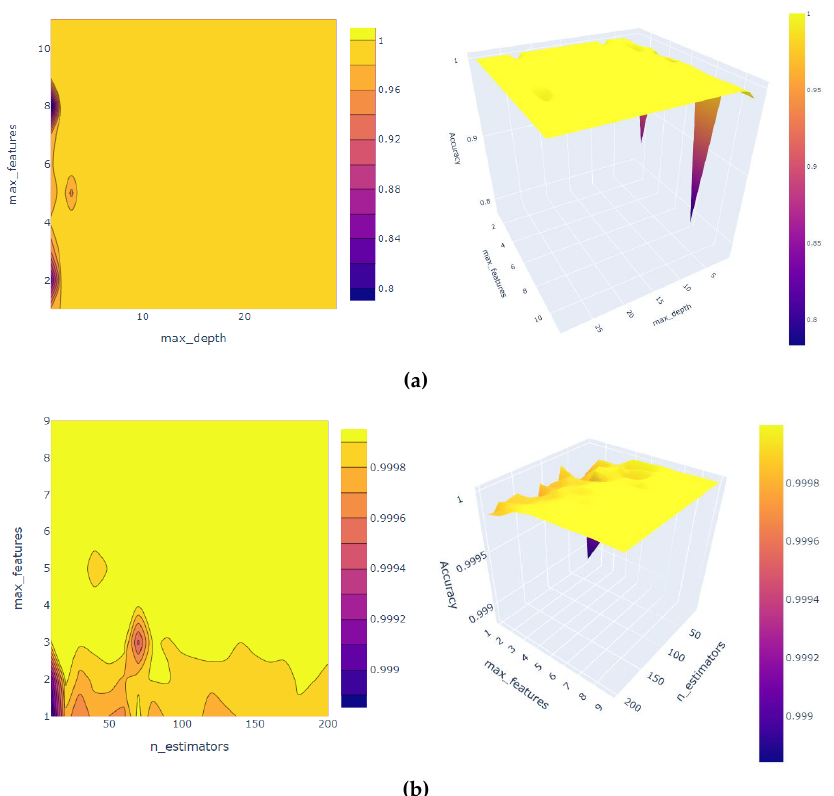
Figure 10. 2D contour and the 3D surface of hyperparameters tuning for ( a ) DT, and ( b ) RF for the target k rop .